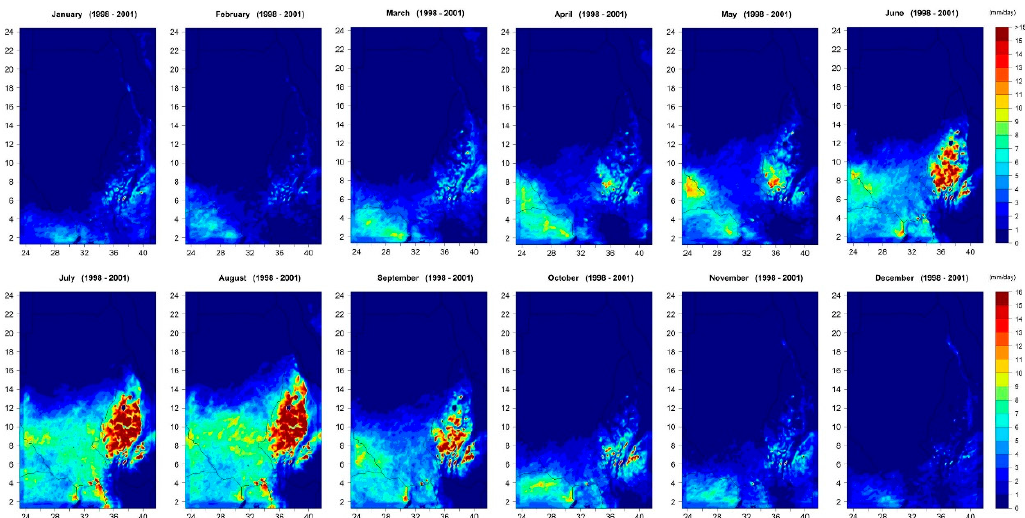
Figure 2. Simulated mean daily precipitation each month (mm/day) over the ENB using the WRF model during the period 1998–2001, Longitude on the horizontal axis and latitude on the vertical axis.